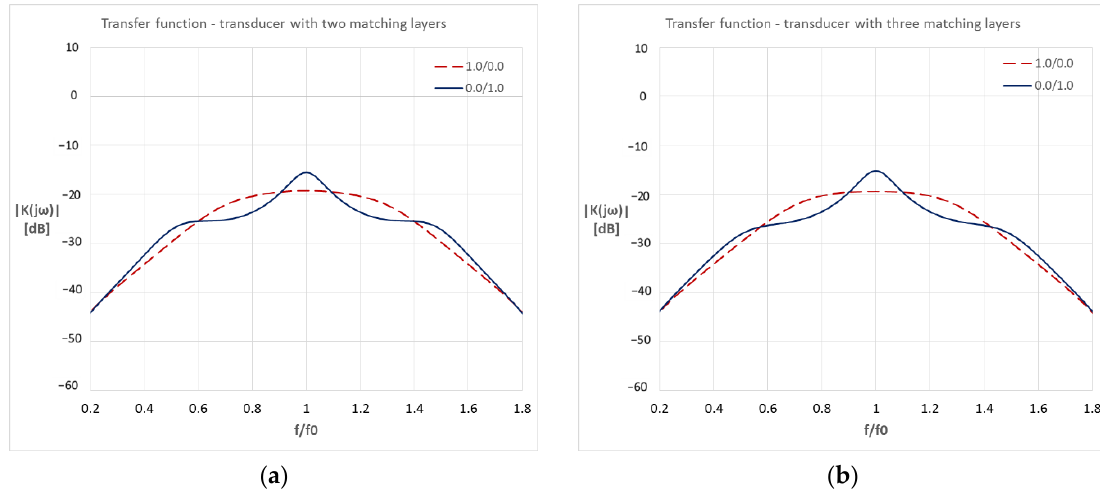
Figure 7. Analysis of the transfer function for the biological medium (skull bone): ( a ) 2 matching layers, ( b ) 3 matching layers.